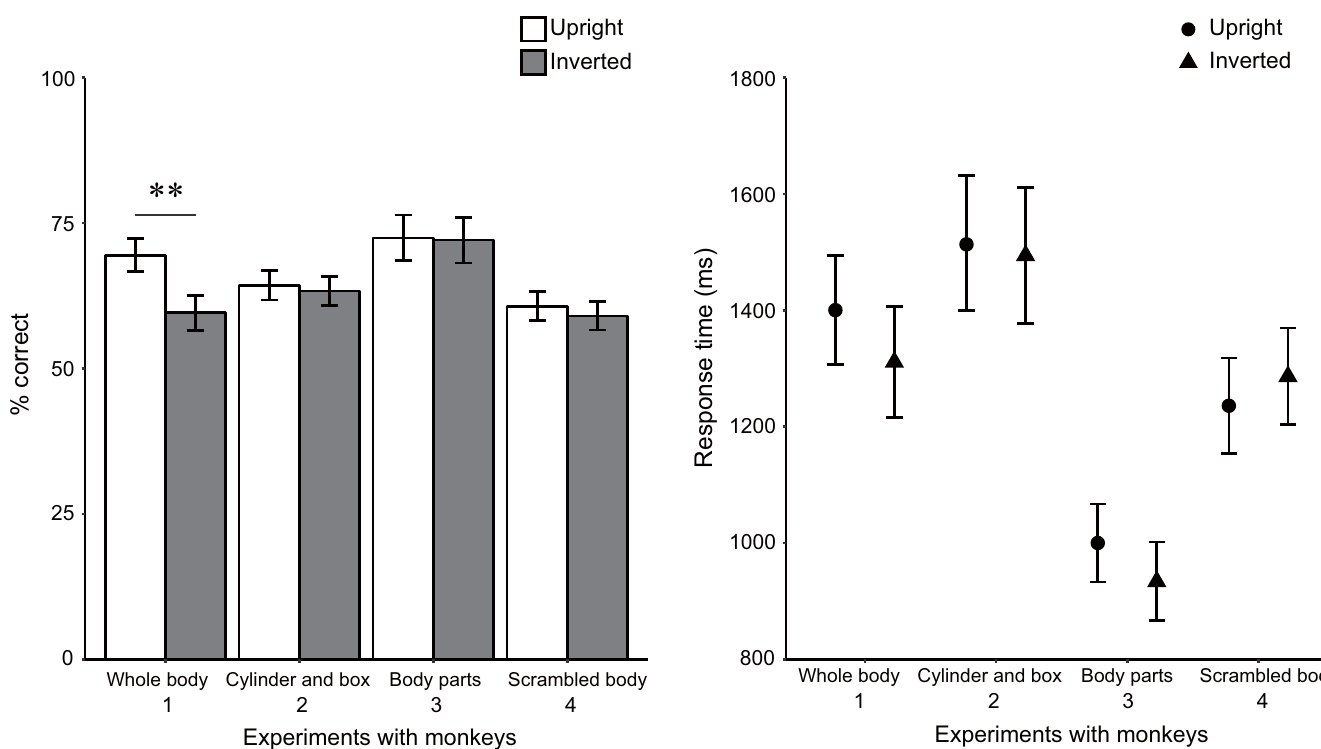
Fig 3. Mean percentages of correct responses and mean response times for correct trials in Experiments 1 to 4. Error bars indicate bootstrapped 95% confidence intervals. (cid:3)(cid:3) p < .01.